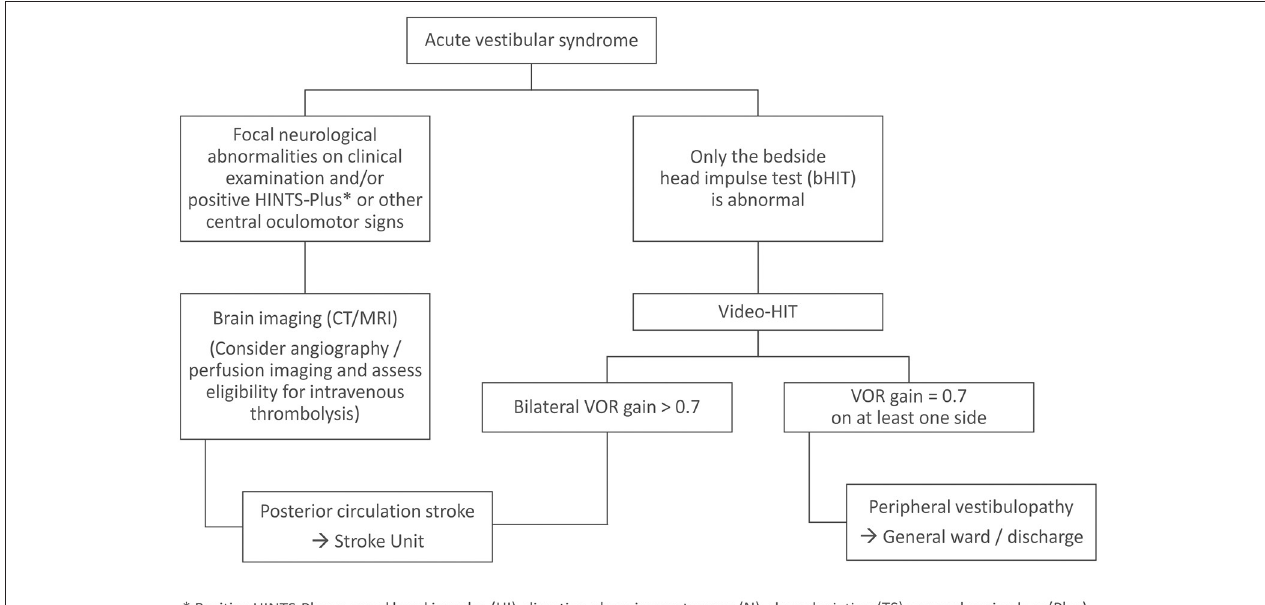
FIGURE 2 | Clinical pathway for patients presenting with AVS to the emergency